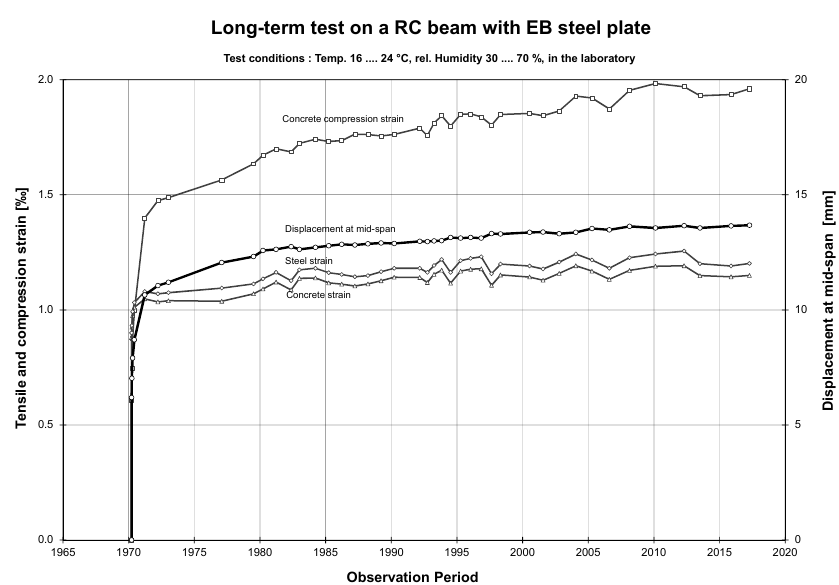
Figure 18. Long-term measurements since 1970 on the RC beam strengthened with an epoxy bonded steel plate.